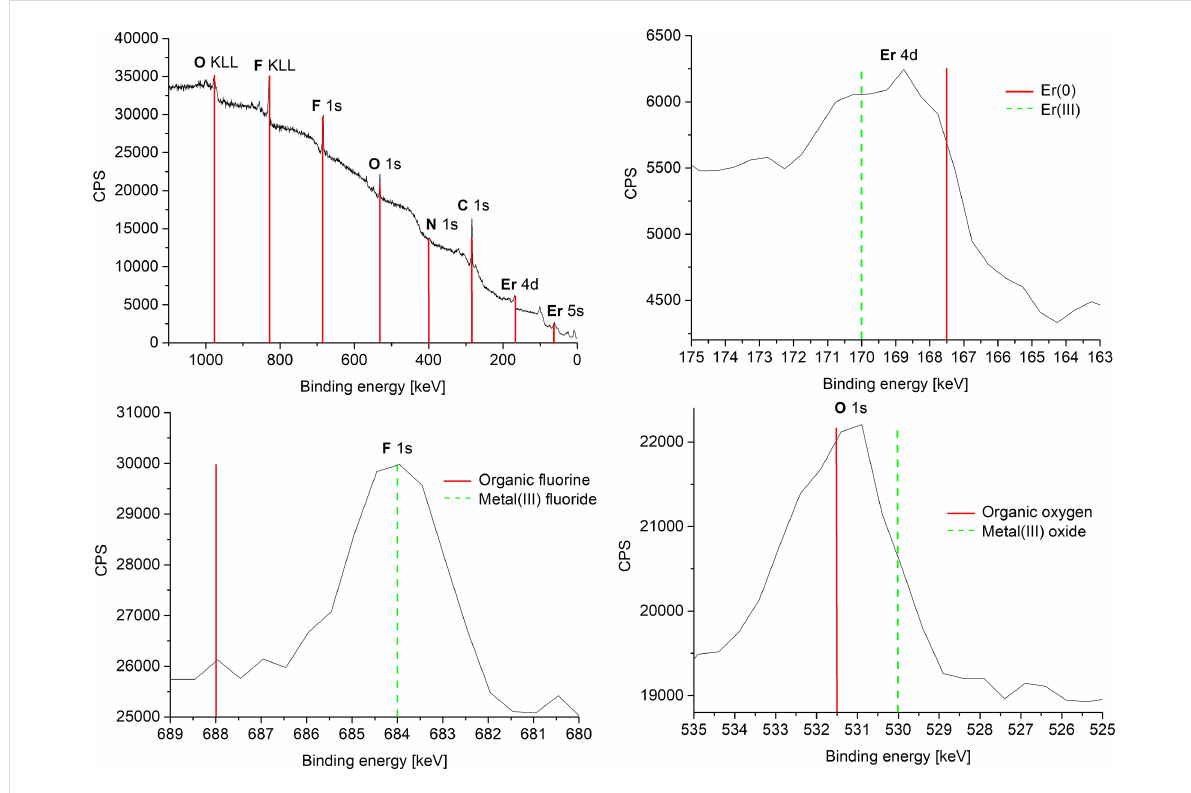
Figure 4: Overview and HR-XPS of 1.0 wt % ErF 3 -NPs in [BMIm][BF 4 ] from Er(amd) 3 . The red and green bars are a guide to the eye on the binding- energy axis.